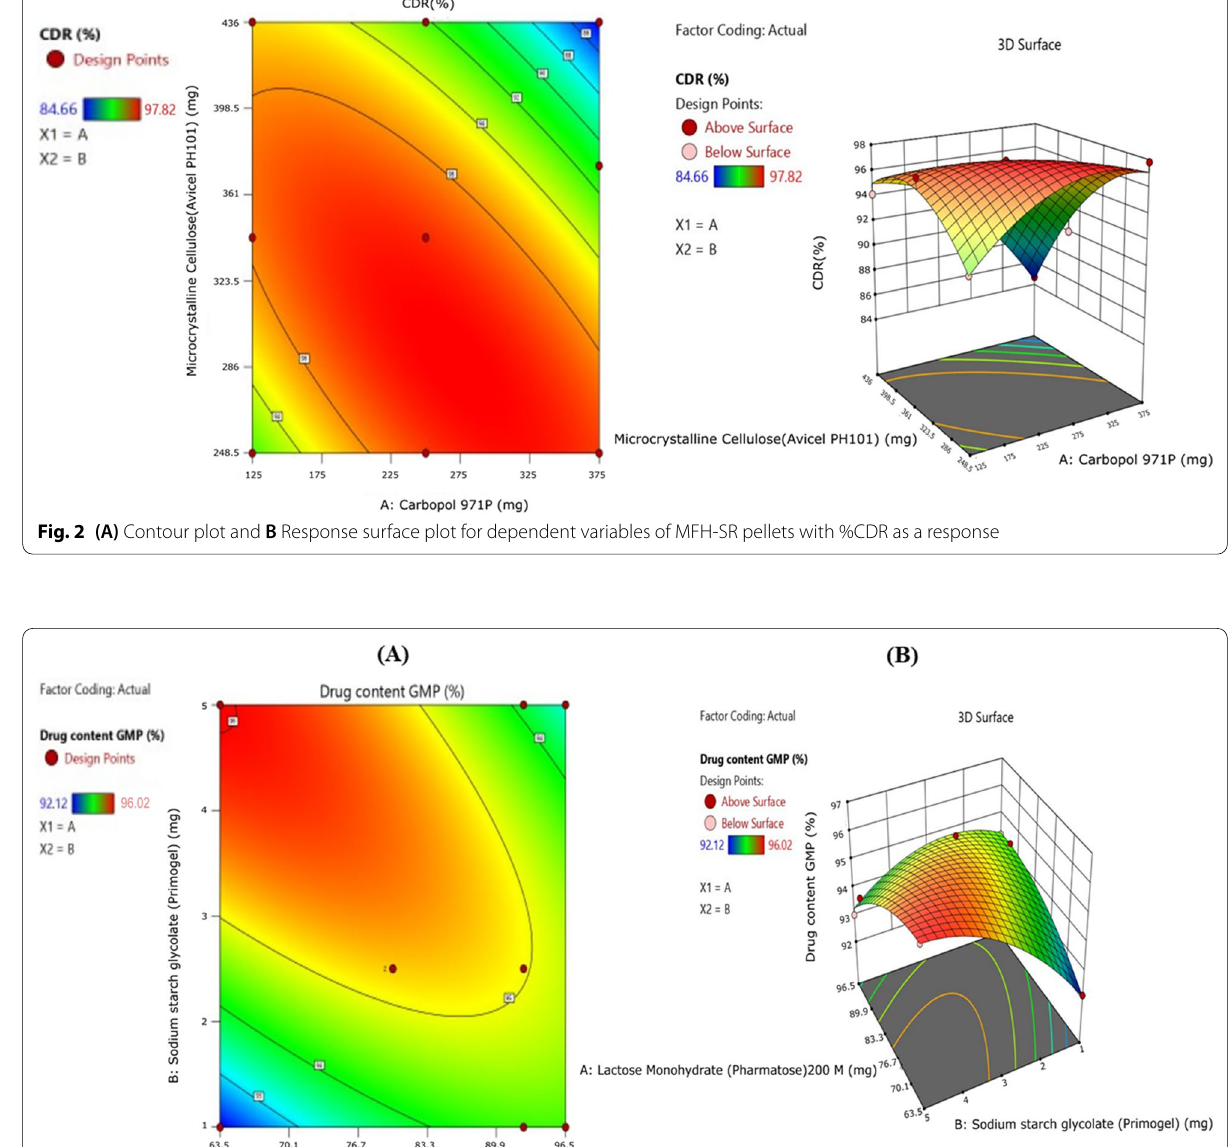
a decrease in the GMP content. The augment in A and B caused an increase in the PGH content. While the com- bined effect of A and B on PGH content is found to be neg- ative; it means a decrease in the PGH content. The ANOVA analysis of results yielded F-value 34.87 and p-value 0.0074 that denotes the significance of the quadratic model. The final equation in terms of coded factors for GMP content;